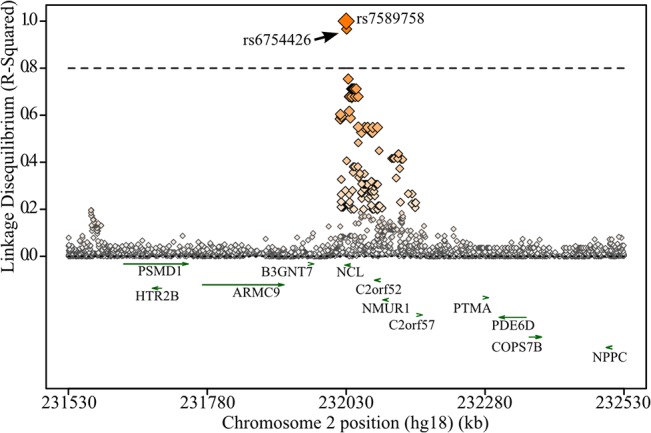
Regional linkage disequilibrium of newly identified SNP associated with NIHL.The location of genome-wide significant SNP, rs7598759 (top large filled diamond), is shown respective to the location of genes (green arrow and arrowhead, length based on size) within a 500 kb fragment of chromosome 2 (2q37.1). Genotyped SNP rs7598759 located within nucleolin gene (NCL) is in strong linkage disequilibrium (r2 > 0.9) with non-genotyped SNP rs6754426 (black arrow). Linkage disequilibrium (r2) is based on Hapmap CEU population with decreasing intensity of colored diamonds indicating decreasing linkage disequilibrium with SNP rs7598759. A SNP was considered in strong LD for r2 > 0.8 (black dashed line). The plot was generated with SNAP [26] using 1000 genomes [27] for the chromosomal position of SNPs.